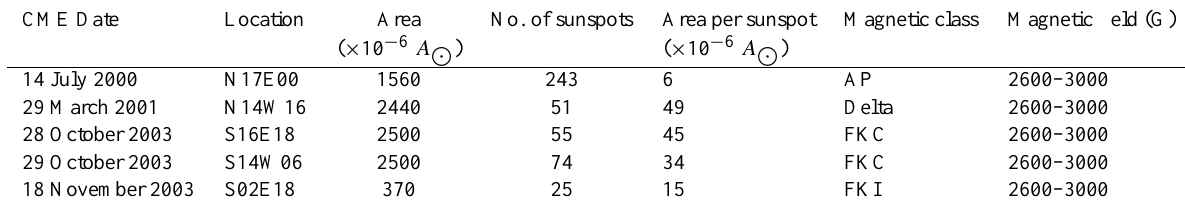
Table 2. Comparison of source active regions associated with